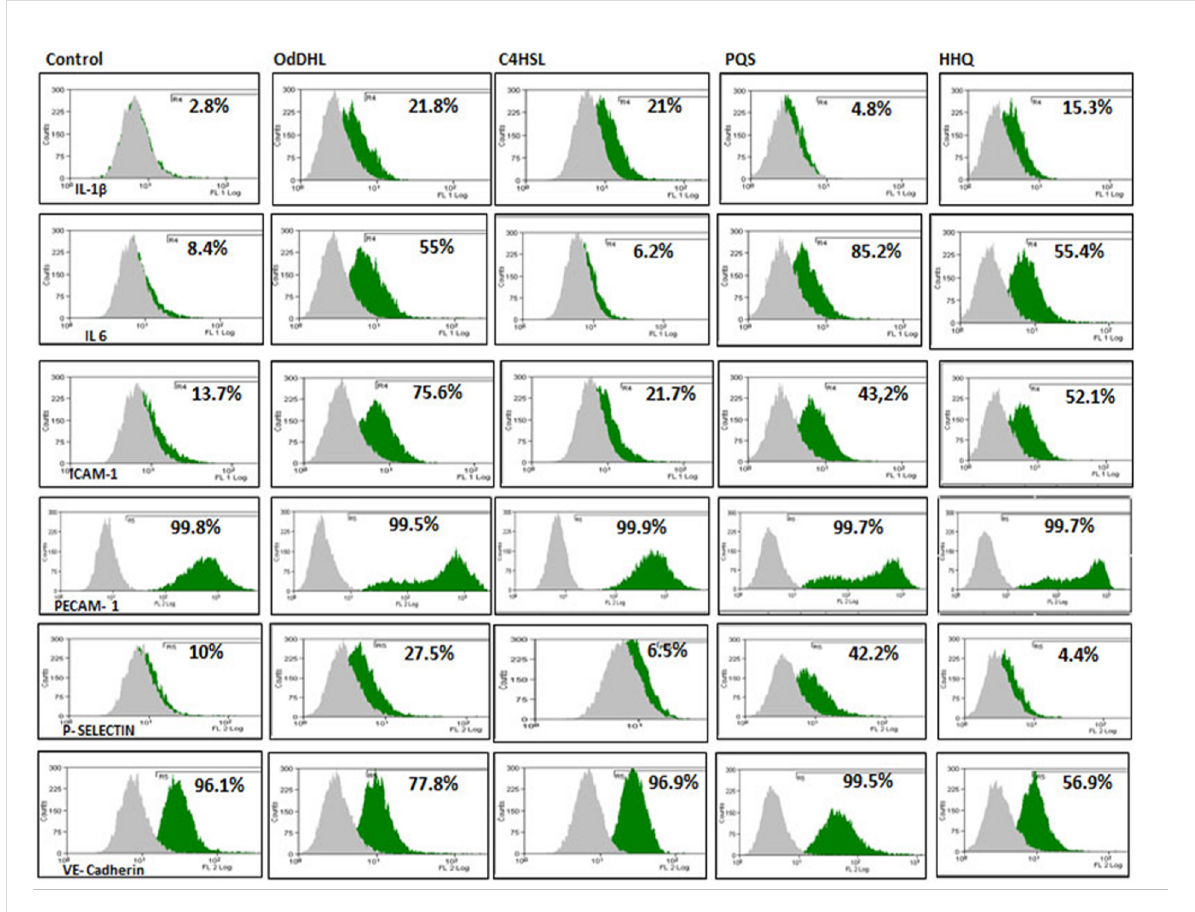
Figure 4: Flow cytometry assays for inflammatory (IL-1 β , IL-6), and adhesion markers (ICAM-1, PECAM-1, P-selectin and VE-cadherin) in endotheli- al cells treated with PAO1 and QSSMs (* P < 0.05, Bonferroni post test of medians of 3 independent experiments performed in triplicate ( n = 3)).